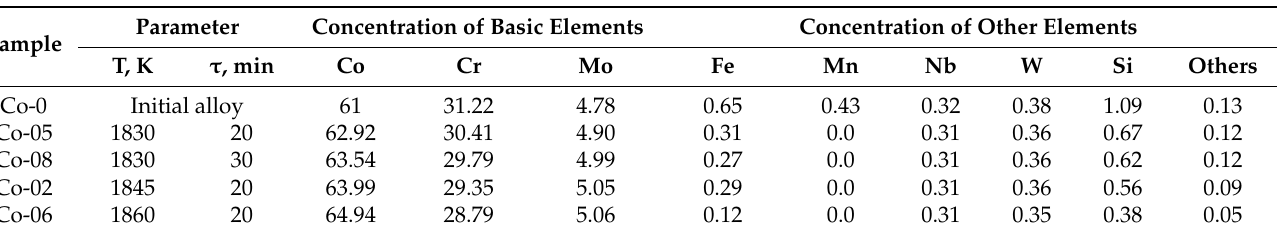
Table 1. Process parameters and chemical compositions (mass %) of the specimens before and after EBMR.